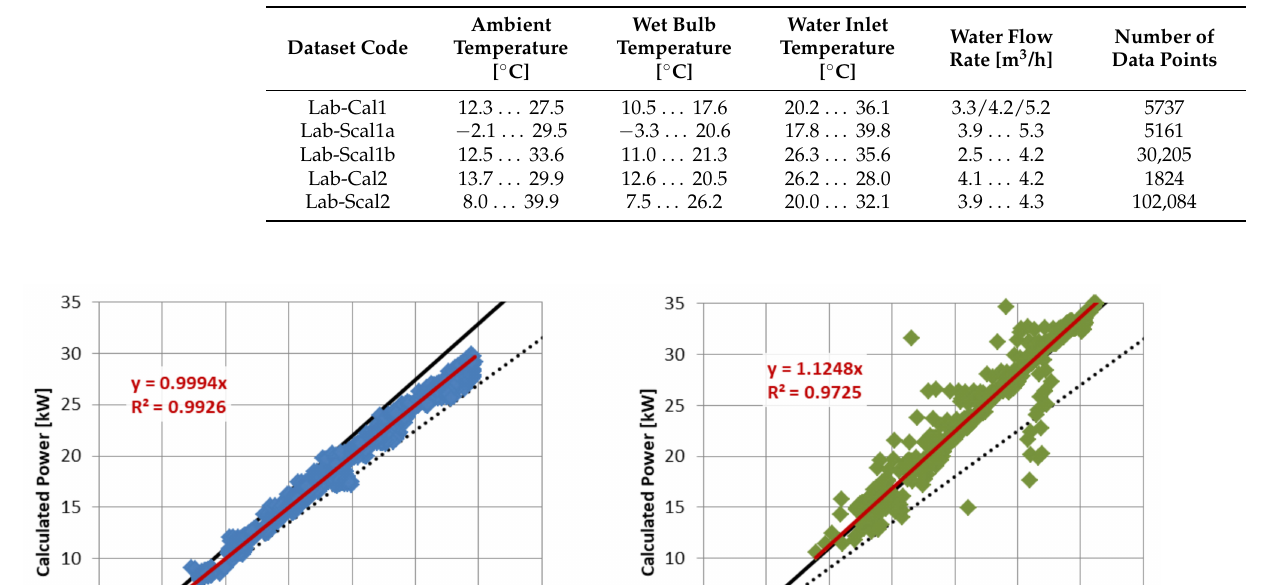
Table 4. Overview over the datasets of the laboratory cooling tower used for model calibration and evaluation; ranges are marked with “MIN . . . MAX”, steps are delimited with “/”.